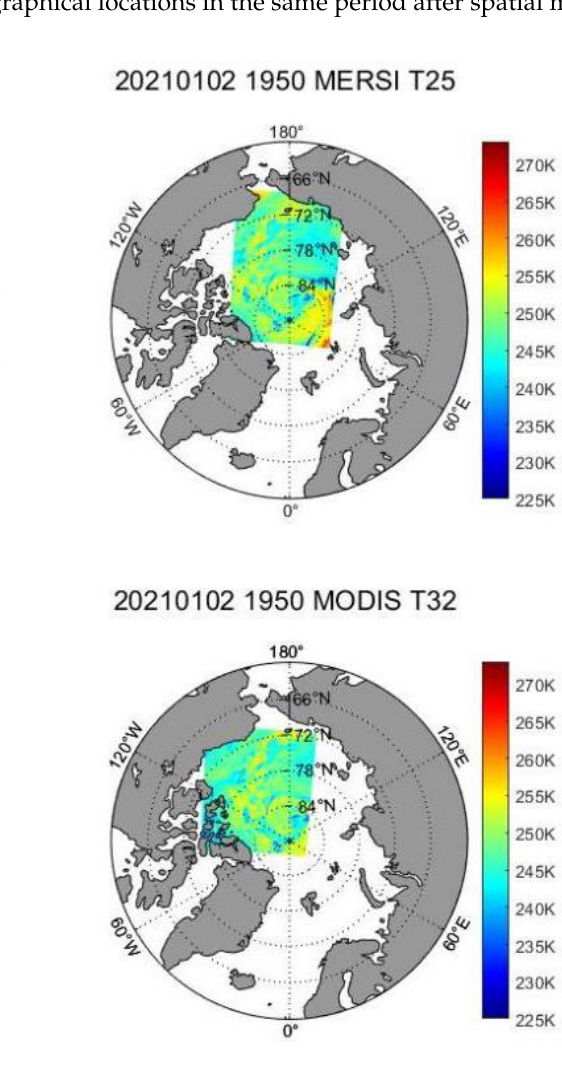
Figure 2. MERSI (channels 24 and 25) and MODIS (channels 31 and 32) thermal infrared T b data before spatial matching at 19:50 on 2 January 2021.